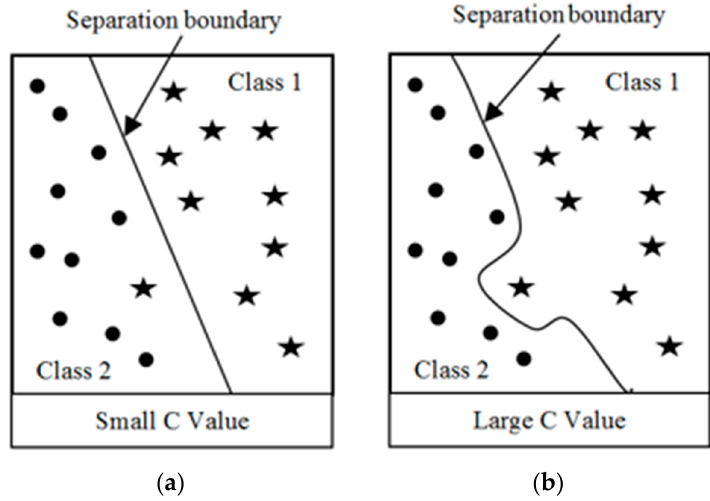
Figure 6. Effect of cost parameter C on classification of data. ( a ) Small C value ( b ) Large C value.